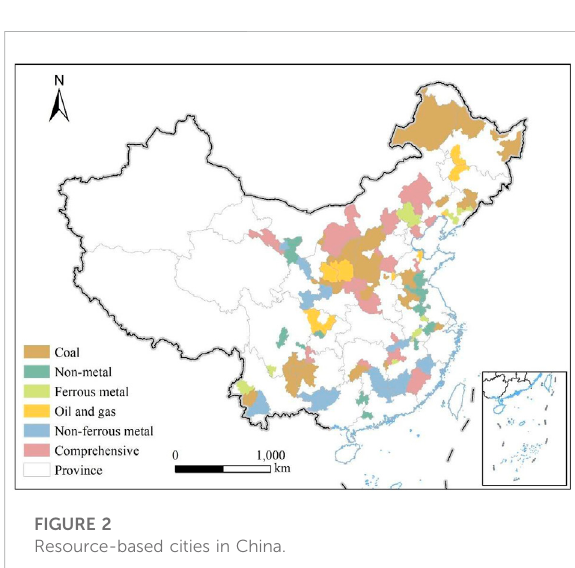
FIGURE 2 Resource-based cities in